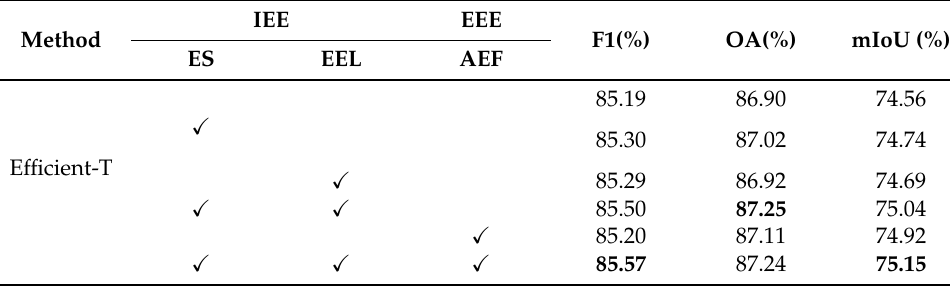
Table 8. The ablation study of edge processing methods.